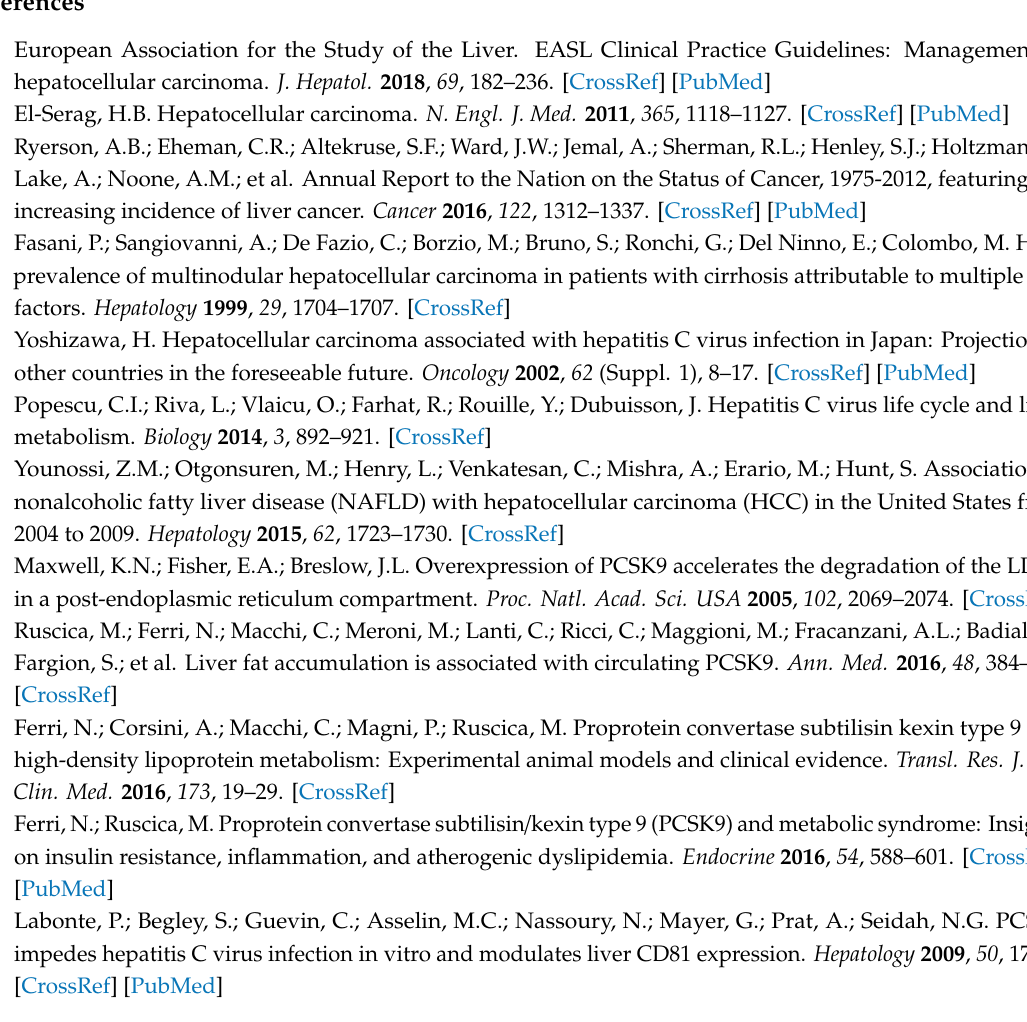
Figure S1: Cholesterol and TG levels in patients HCV positive divided by virus genotype. (A) Total cholesterol; (B) TG; (C) LDL-C. Table S1: Correlation analysis in HCC HCV + patients. Table S2: Correlation analysis in HCC HCV- patients. Table S3: MELD values between patients with di ff erent HCV genotype. Table S4: Percentage of HCC positivity in di ff erent genotype of HCV infected